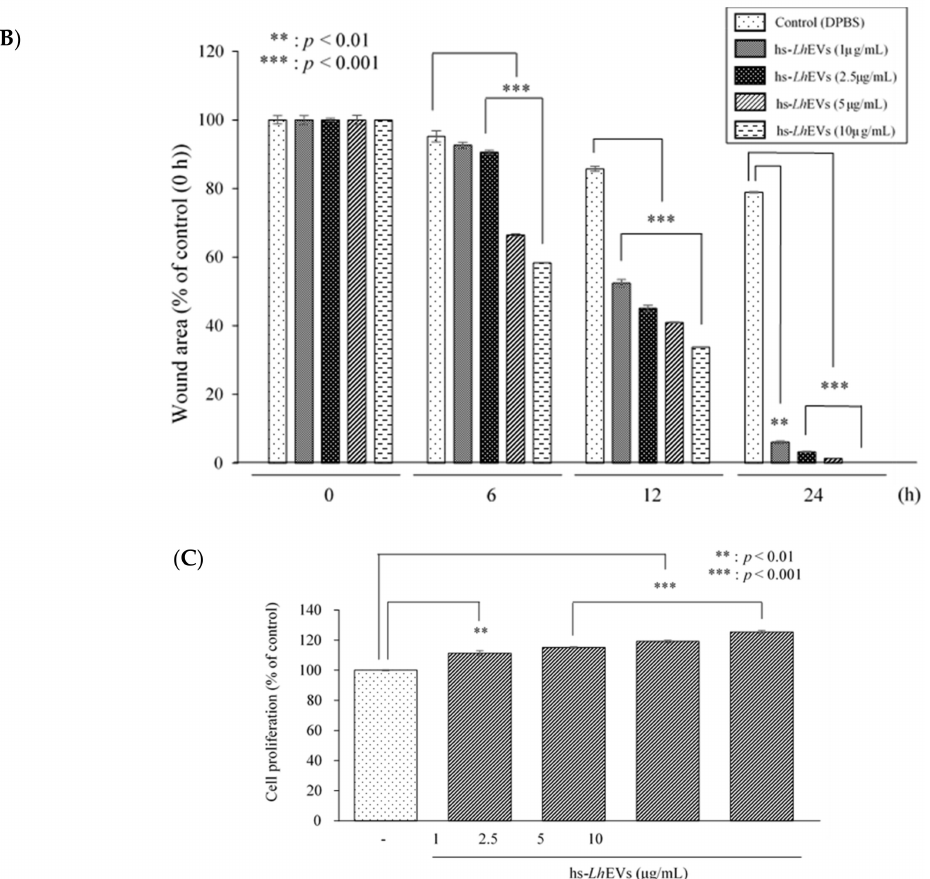
Figure 4. Cell migration and proliferation inductive effects of hs- Lh EVs in human follicle dermal papilla cells (HFDPCs). ( A ) Cell migration as determined by a wound healing assay, treated with 1, 2.5, 5, 10 µ g/mL hs- Lh EVs in a time-dependent manner. ( B ) Quantification of migrated cells shown in ( A ). ( C ) Cell proliferation as assessed with a CCK-8-based assay performed on HFDPCs treated with hs- Lh EVs in time- and dose-dependent manners. Mean ± SD of experiments are shown. ** p < 0.01; *** p < 0.001—Student’s t -test was used. Bl EVs, Bifidobacterium longum -derived extracellular